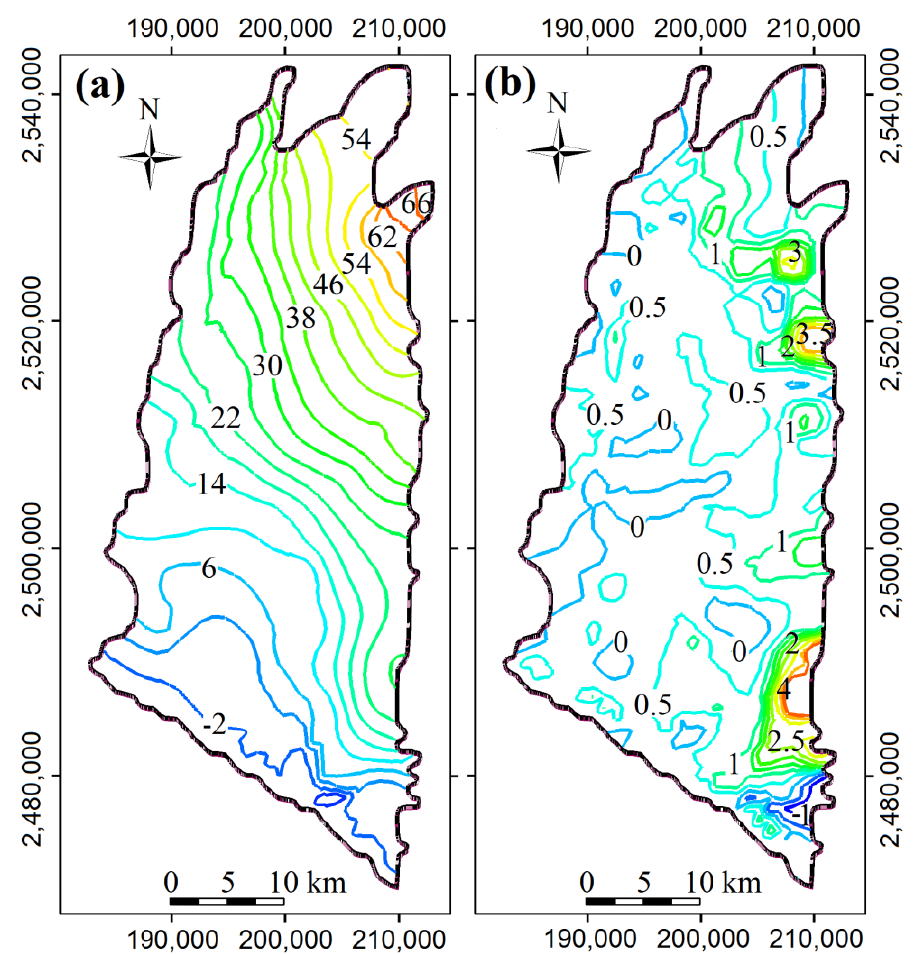
Figure 7. The simulated groundwater hydraulic head distributions: ( a ) the distribution of averaged groundwater hydraulic heads in the PPGB; ( b ) di ff erences of the averaged hydraulic heads between wet and dry seasons through the three-year simulation period.